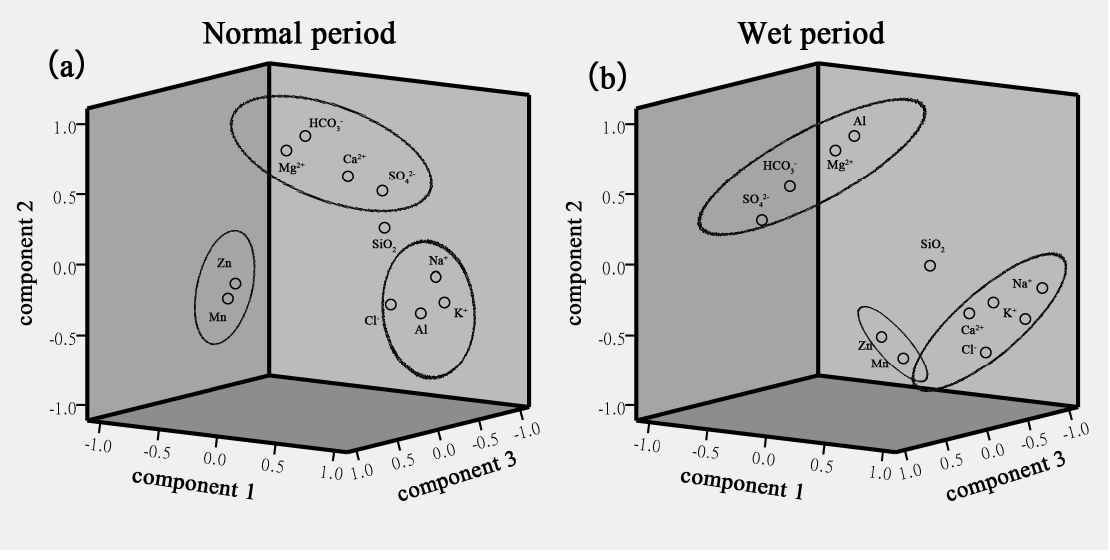
Figure 8. Component plot in the rotated (PCA) and wet period. ( a ) PC1, PC2 and PC3 loading of the Yarlung Tsangpo River basin in normal period. ( b ) PC1, PC2 and PC3 loading of the Yarlung Tsangpo River basin in wet period. Table 3. Principal component analysis (PCA) of elements in river waters.